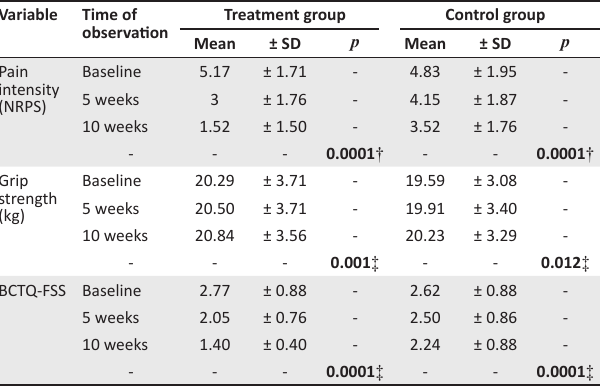
For the BCTQ-FSS, the paired t -test showed a statistically TABLE 2: Group means and standard deviation for pain intensity, grip